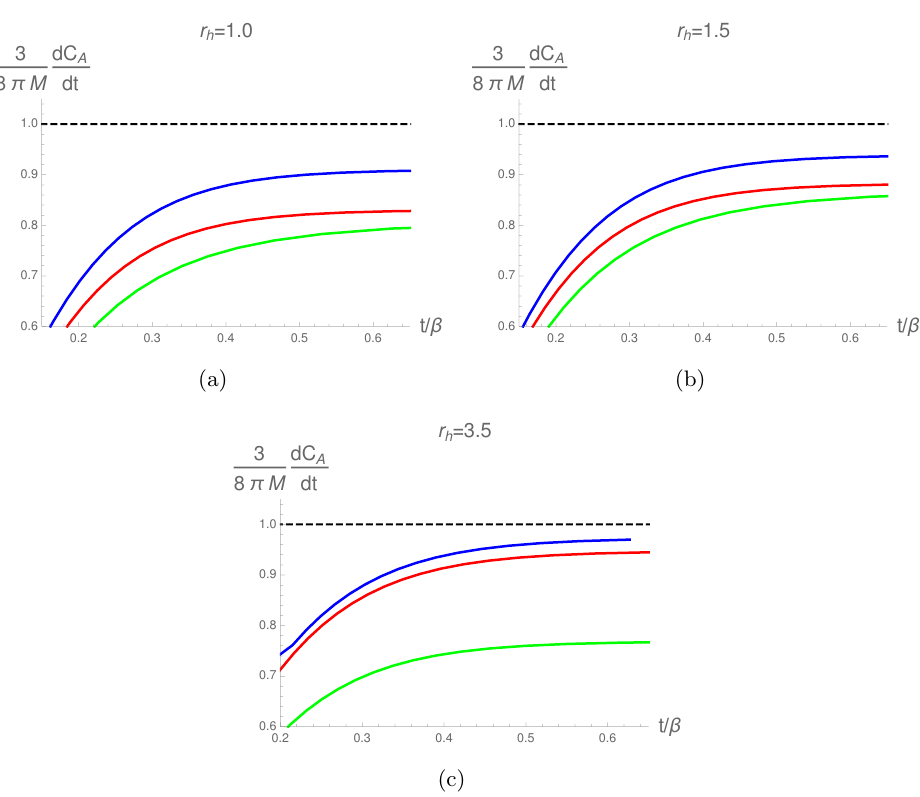
Figure 8 . dC V as a function of t=(cid:12) for di(cid:11)erent values of the horizon radius r h . Here we have used dt d = 4 and n = 1, and as before the blue curves indicate a = 0 : 05, the red curves a = 0 : 1 and the green curves a = 0 :